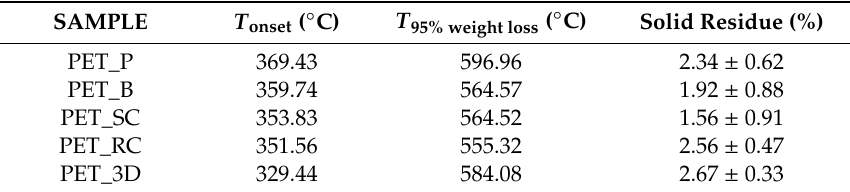
Table 3. Tonset and solid residue from TGA curves.